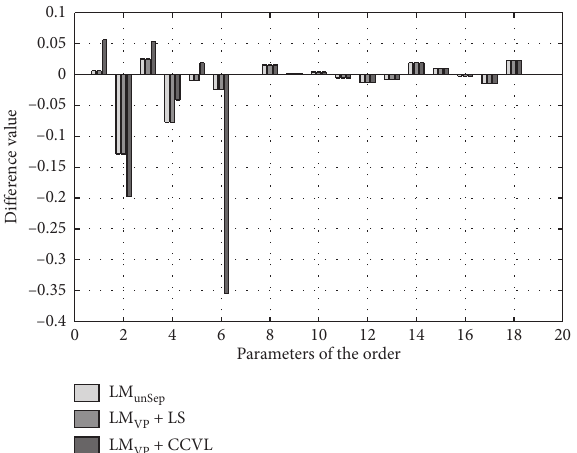
Figure 3: Differences between true value and estimation of pa- rameters obtained by the three methods for Example